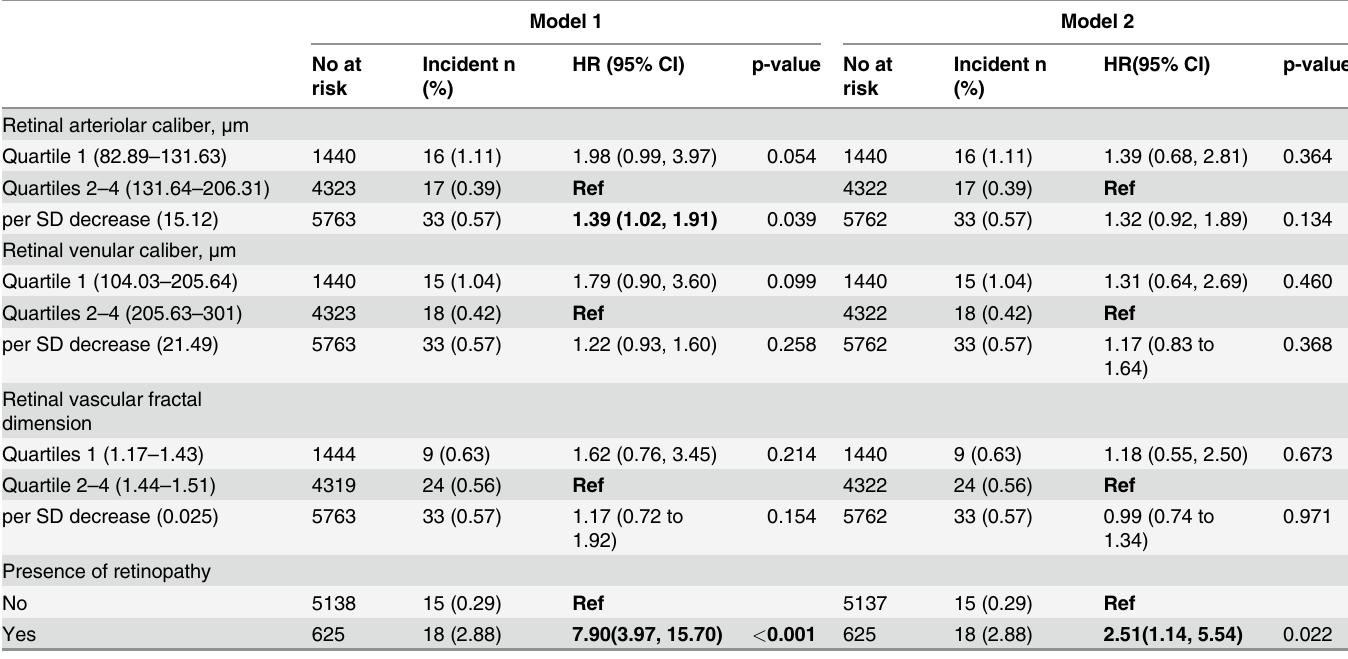
Table 4. Relation of retinal vascular caliber, retinal vascular fractal dimension and retinopathy signs to risk of end stage renal